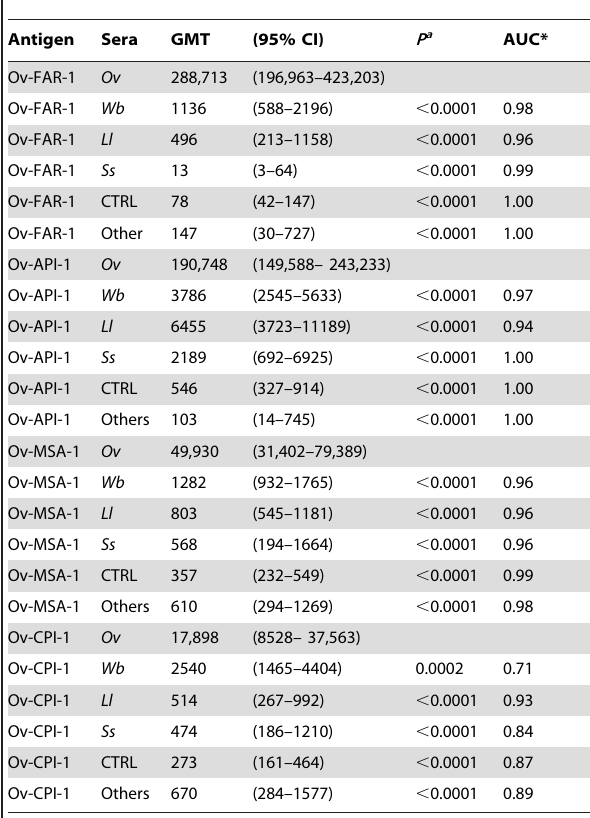
Table 3. Antibody titer characteristics for the Ov